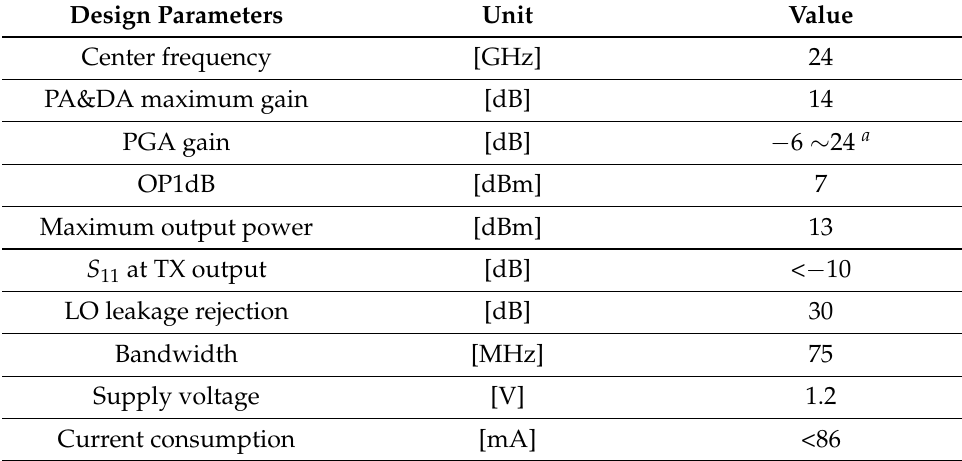
Table 3. Transmitter design requirements.